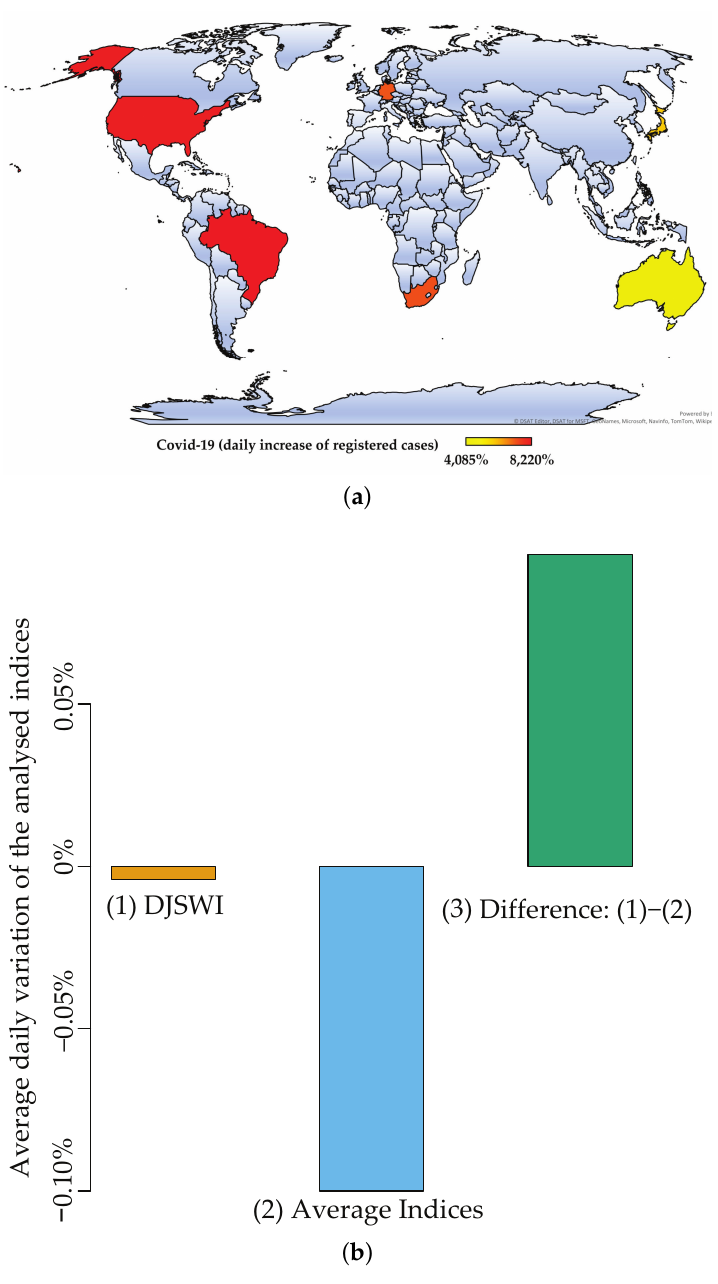
Figure 3. Overview of the stock market indexes and the financial markets analyzed: ( a ) Growth in the number of cases in each country surveyed, ( b ) benchmark of the behavior of the DJSWI index against the other stock market indices